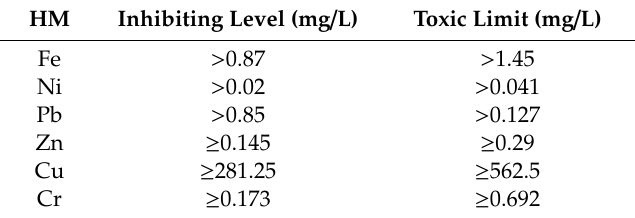
Table 4. Inhibiting level and toxic threshold of olive mill waste during the anaerobic digestion process. HM Inhibiting Level (mg / L) Toxic Limit (mg / L) Fe > 0.87 > 1.45 Ni